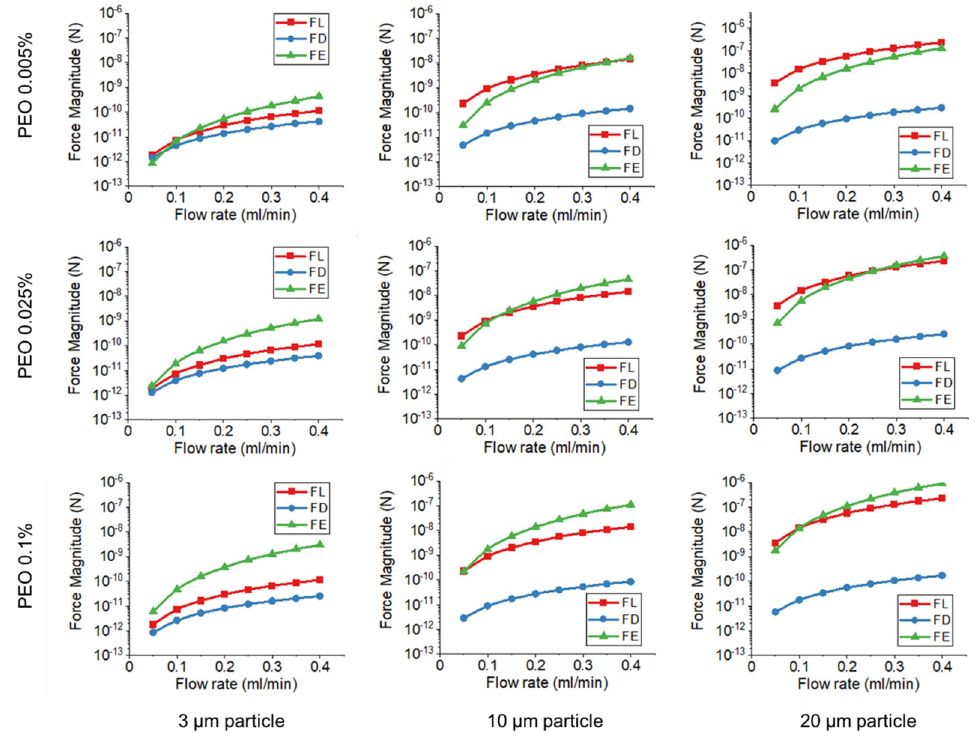
Figure 6. Force magnitude of F L , F E , and F D in medium concentration PEO flow.